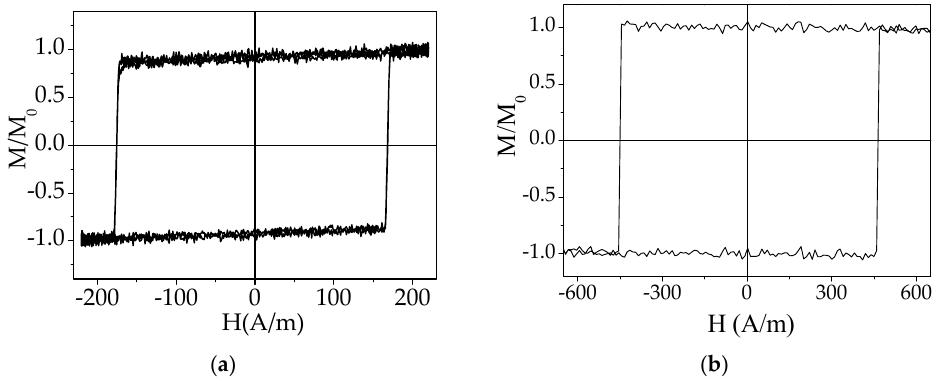
Figure 15. Hysteresis loops of as-prepared Fe 70.8 Cu 1 Nb 3.1 Si 14.5 B 10.6 ( ρ = 0.38) ( a ) and Fe 38.5 Co 38.5 B 18 Mo 4 Cu 1 ( ρ = 0.6) ( b ) microwires. Adapted from [70,71], respectively.